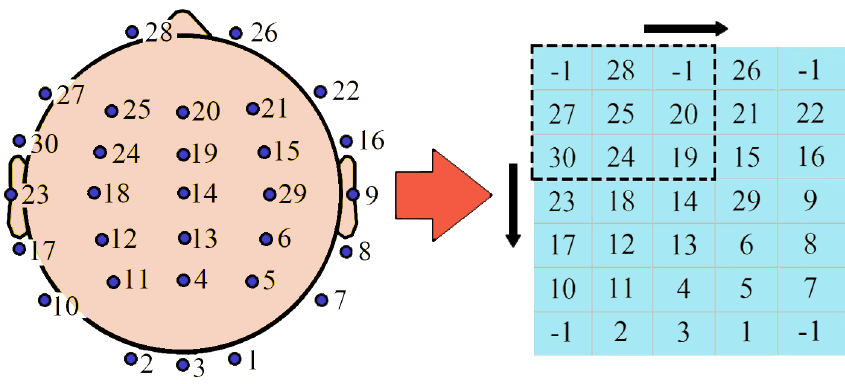
Figure 8. Matrix representation of the channel